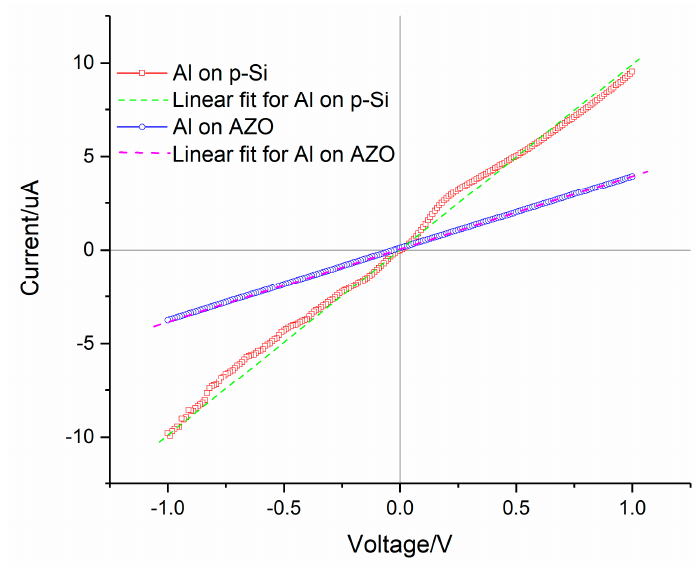
Figure 2. The Current–Voltage (I-V) curves for two Al electrodes on p-Si and n-AZO, respectively.